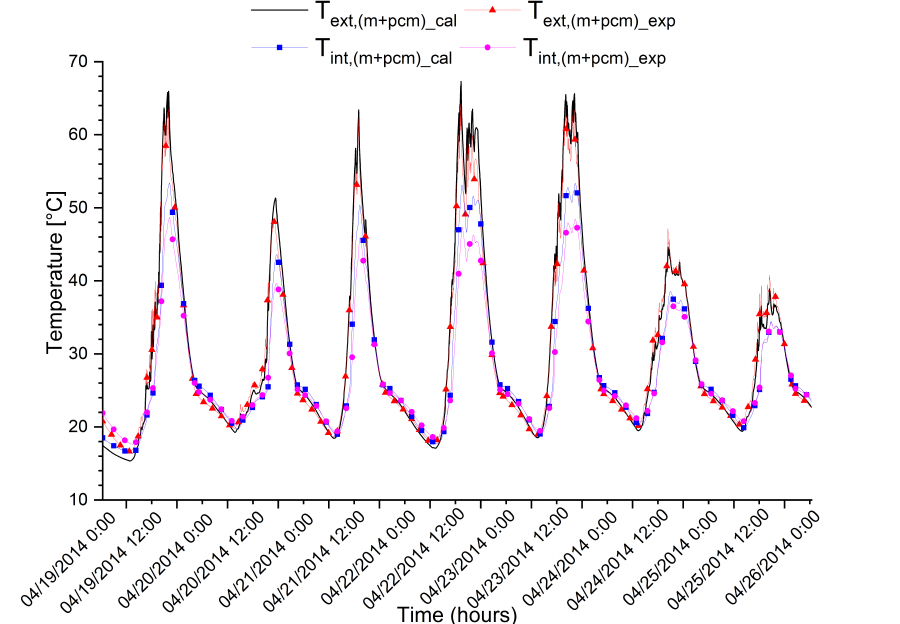
Figure 11. Comparison of temperatures on both sides of the storage wall (model results and experimentation). T ext,(m+pcm)_cal and T ext,(m+pcm)_exp denote respectively the evolution in numerical and experimental temperatures on the exterior surface of the storage wall containing PCM; T int,(m+pcm)_cal and T int,(m+pcm)_exp denote respectively the evolution in numerical and experimental temperatures on the interior surface of the storage wall containing